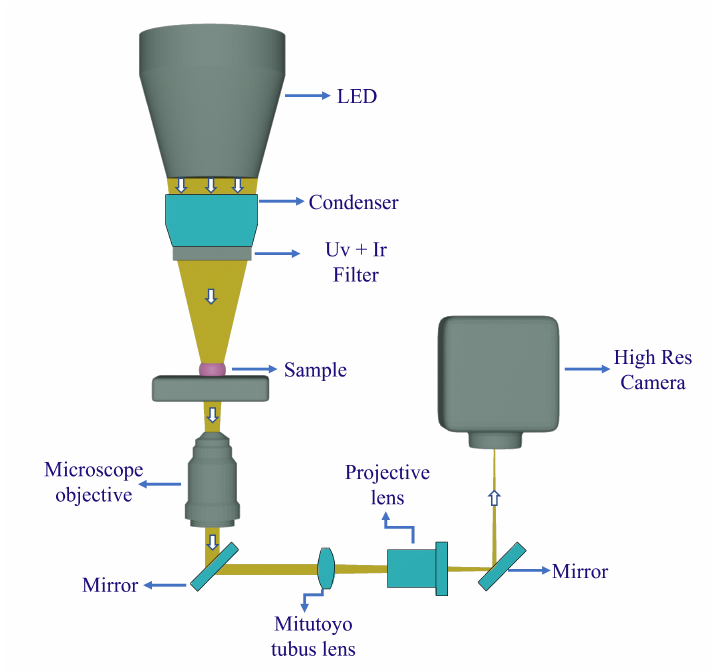
Figure 1. The scheme of the nanoscope (ICS